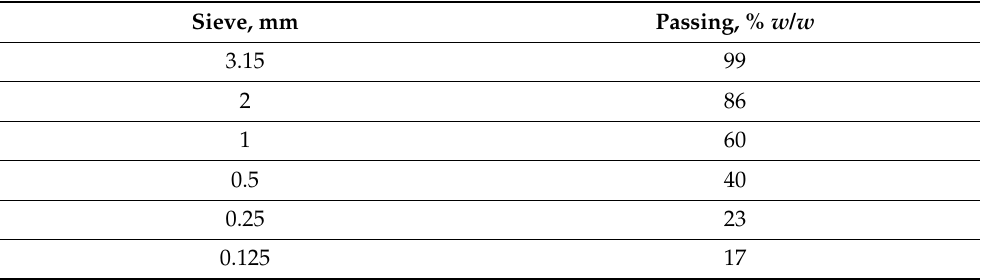
Table 1. Particle size distribution of component B (EN